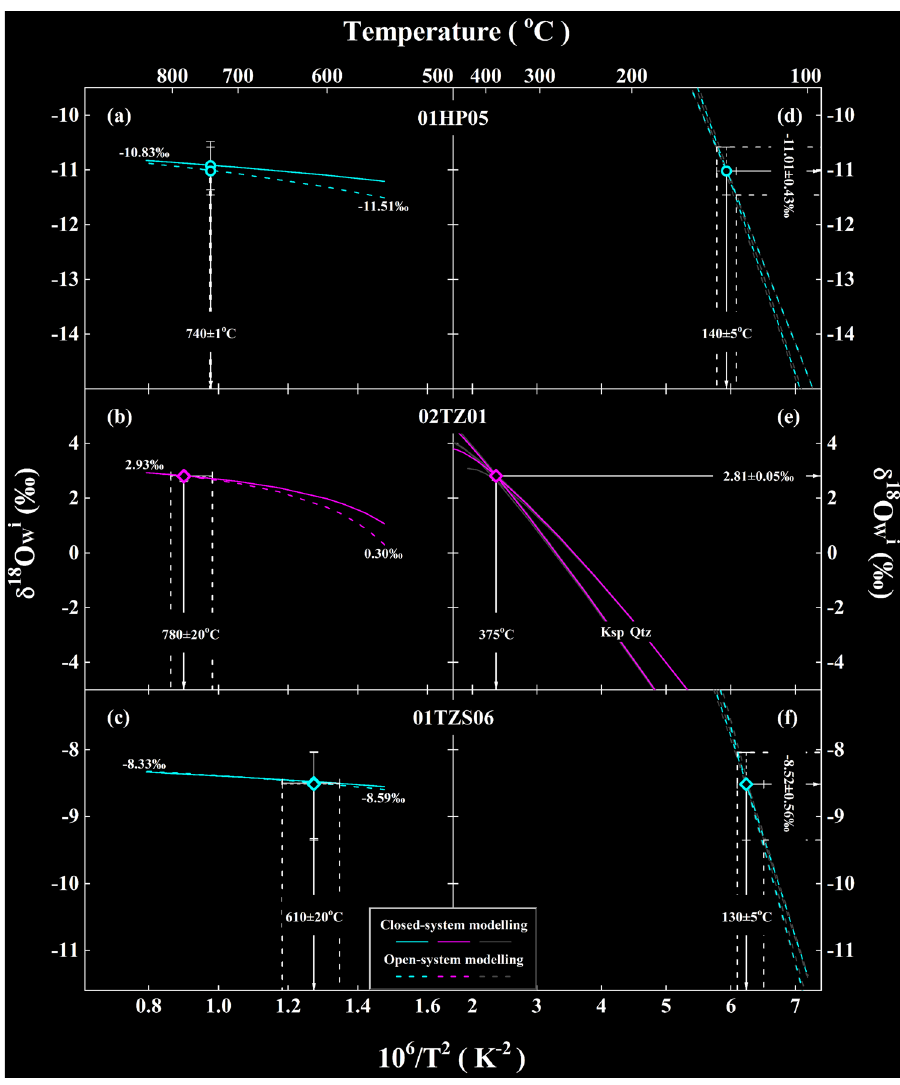
18 O i Figure 4. The relationship between temperatures and δ W values theoretically inverted from the Dabie 18 O i orogen. Curves with gray envelopes denote δ W values theoretically inverted from the early Cretaceous post- collisional granitoids (samples 01HP05 and 02TZ01) and the Triassic gneissic country rock (sample 01TZS06), respectively. Arrowed vertical lines with envelopes illustrate the maximum variation of magmatic ( a,b ) and metamorphic ( c ) as well as re-equilibration temperatures ( d–f ) adopted for the studied samples. Symbol points 18 O i with error bars denote the maximum variability of δ W values and temperatures. Other details see